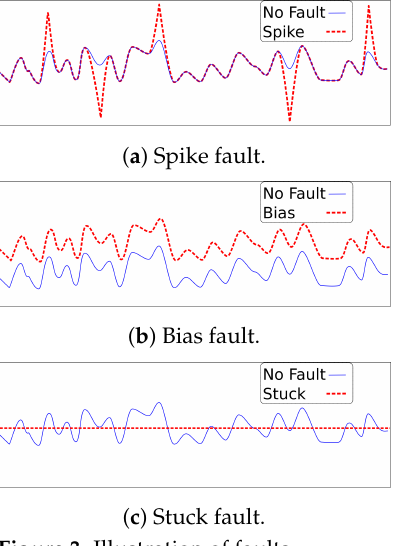
Figure 3. Illustration of faults.